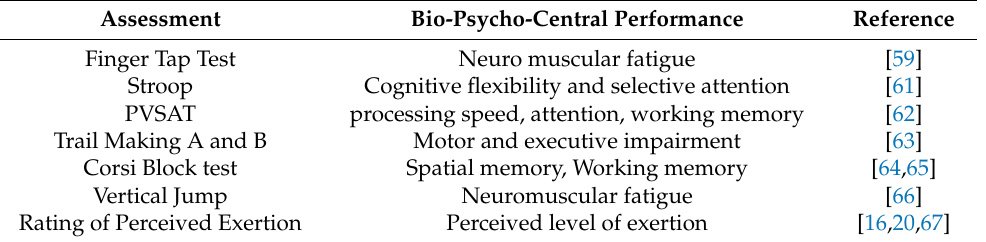
Table 1. Assessment Battery.